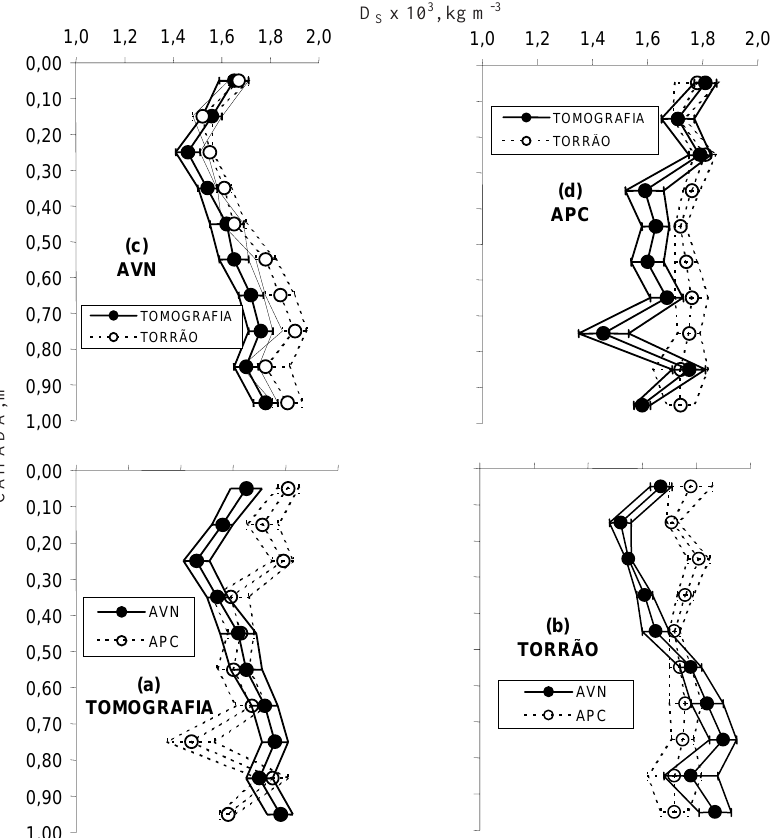
Figura 2. Valores médios de densidade do solo (D ) com seus respectivos desvios (intervalo de ± sssss ), S determinados em camadas de 0,10 m, da superfície até 1 m de profundidade, considerando-se as duas áreas avaliadas, área sob vegetação nativa (AVN) e área sob cultivo constante e irrigada por pivô central (APC), segundo a aplicação do método da tomografia computadorizada e do torrão impermeável.